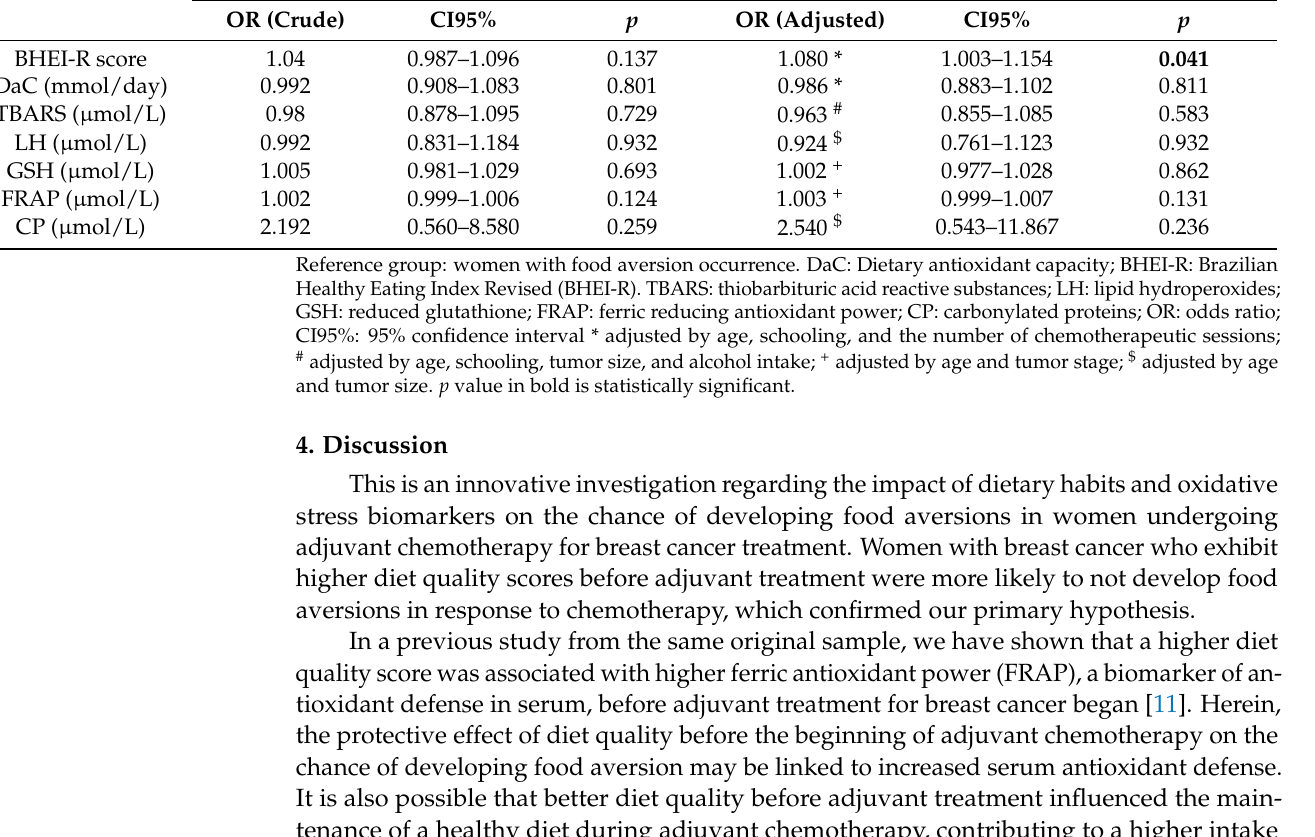
Table 3. Association between dietary antioxidant capacity (DaC), diet quality according to the Brazilian Healthy Eating Index Revised (BHEI-R) and oxidative stress biomarkers and non- occurrence of food aversions (n = 73).